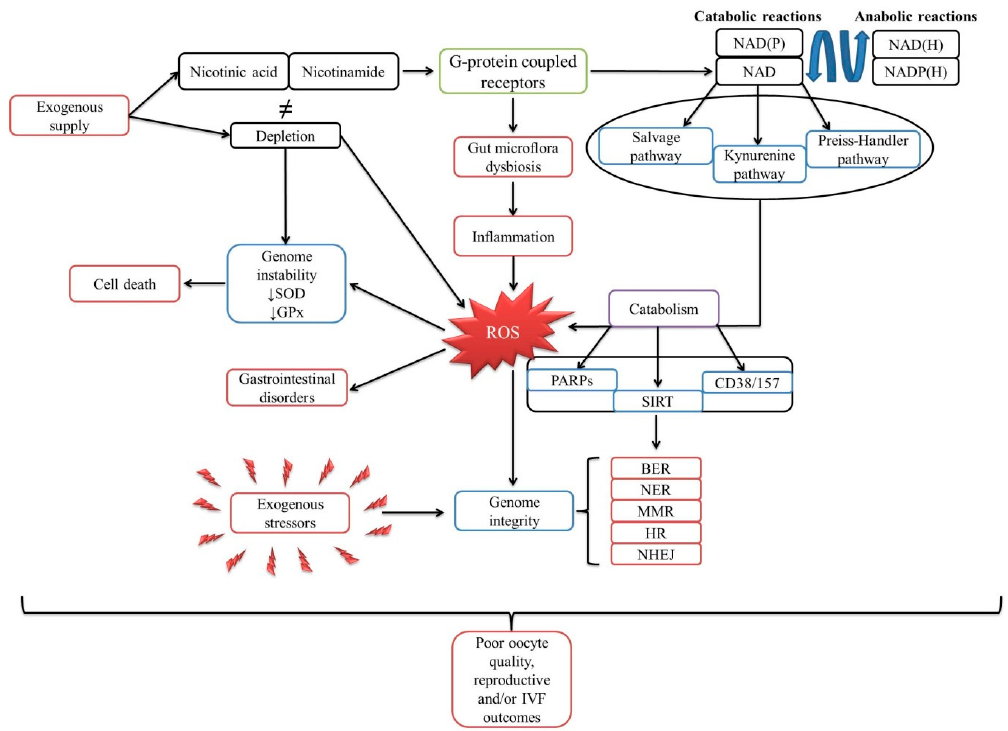
Figure 1. Schematic representation of niacin’s biological cycle. Once ingested, the G-protein-coupled receptors initiate intracellular responses, and niacin is converted into four specific precursors involved in both anabolic and catabolic reactions. However, if the gut microflora is disrupted, it produces a large amount of reactive oxygen species, which influences genome structure. If a depletion occurs, NAD is synthesized through three specific pathways, which strongly correlate with three NAD-consuming enzymes, but also with the production of reactive oxygen species. Subsequently, five highly specialized mechanisms ensure genome integrity against any exogenous or endogenous stressor(s). In the absence of an exogenous supply of niacin, there is a gradual, progressive instability of the genome, characterized by the inability of the antioxidant system to act e ffi ciently, which ultimately leads to cell death. Cumulatively, all of these aspects could ultimately a ff ect the viability of in vitro fertilization protocols through a deterioration of oocyte